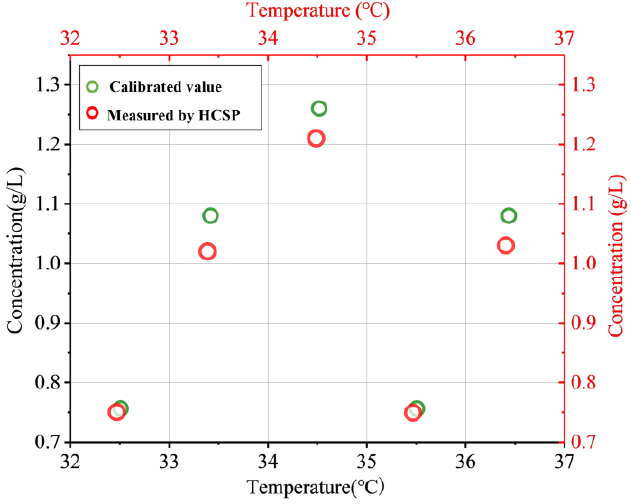
Figure 7. The difference between the calibrated value and value measured by the HCSP.